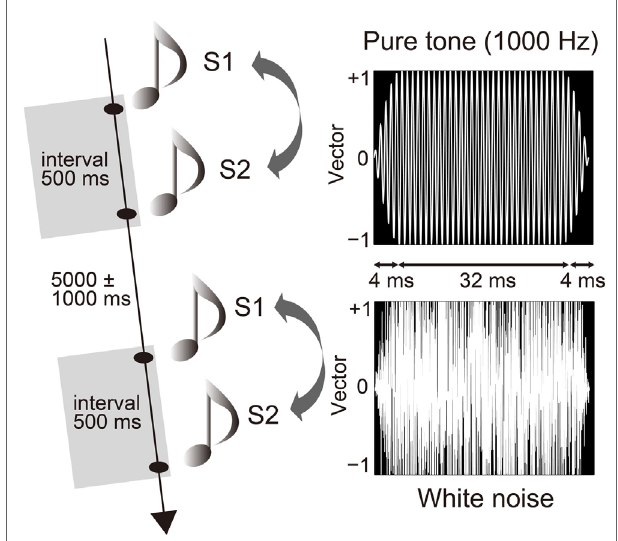
FigUre 1 | Paired-click paradigm and auditory stimuli . The first (S1) and second (S2) stimuli successively stimulated participants with an interval of 500 ms and an inter-trial interval of 5000 ± 1000 ms. Stimulus pairs of pure tone (1000 Hz) and white noise were presented randomly and in equal frequency. Duration of each stimulus was 40 ms with a plateau of 32 ms and a rise and fall of 4